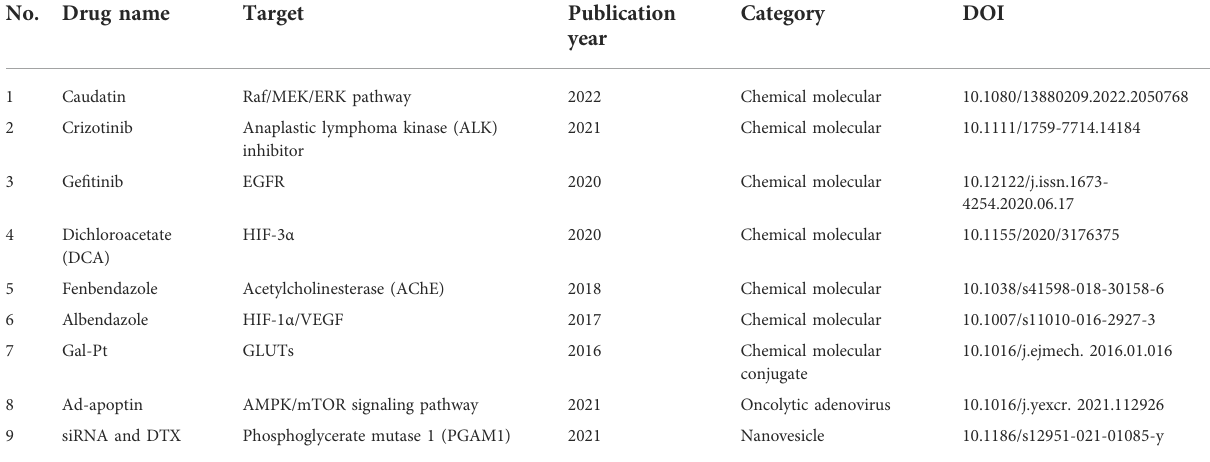
TABLE 2 Small molecules and novel preparations targeting glycolysis in